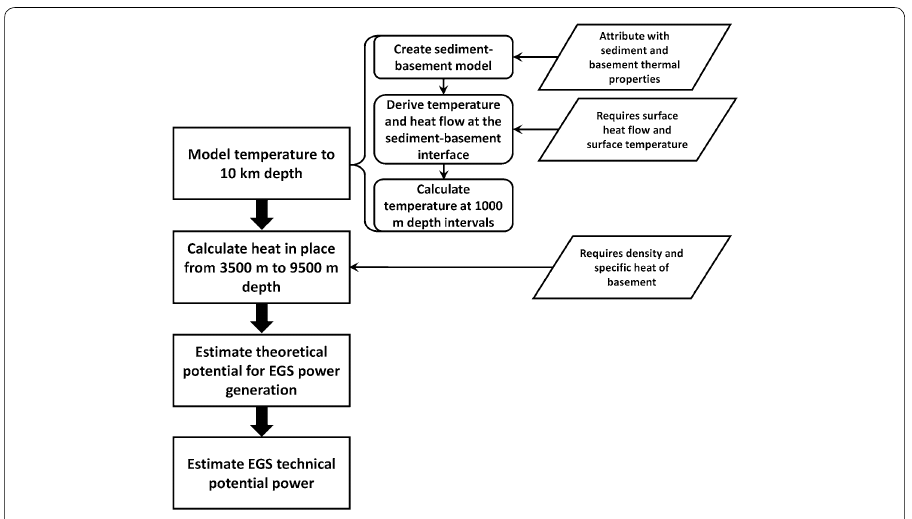
Fig. 1 Simplified workflow diagram of the Beardsmore protocol for estimating EGS